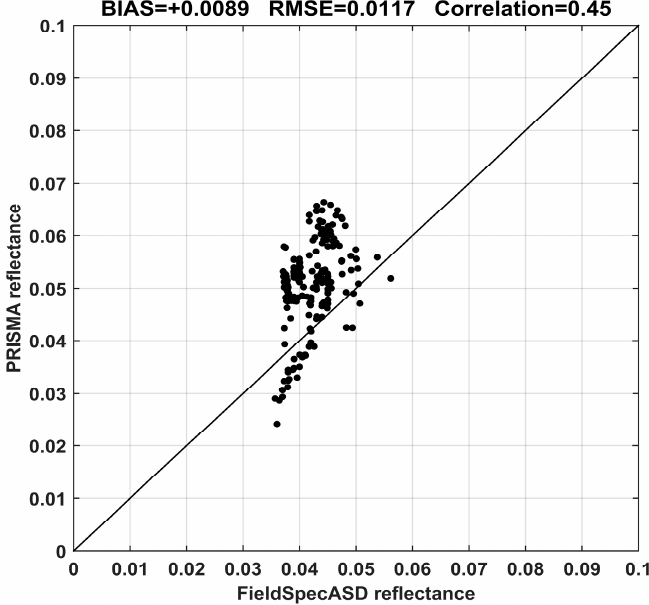
Figure 8. Reflectance profiles of PRISMA (red) and FieldSpec (black).